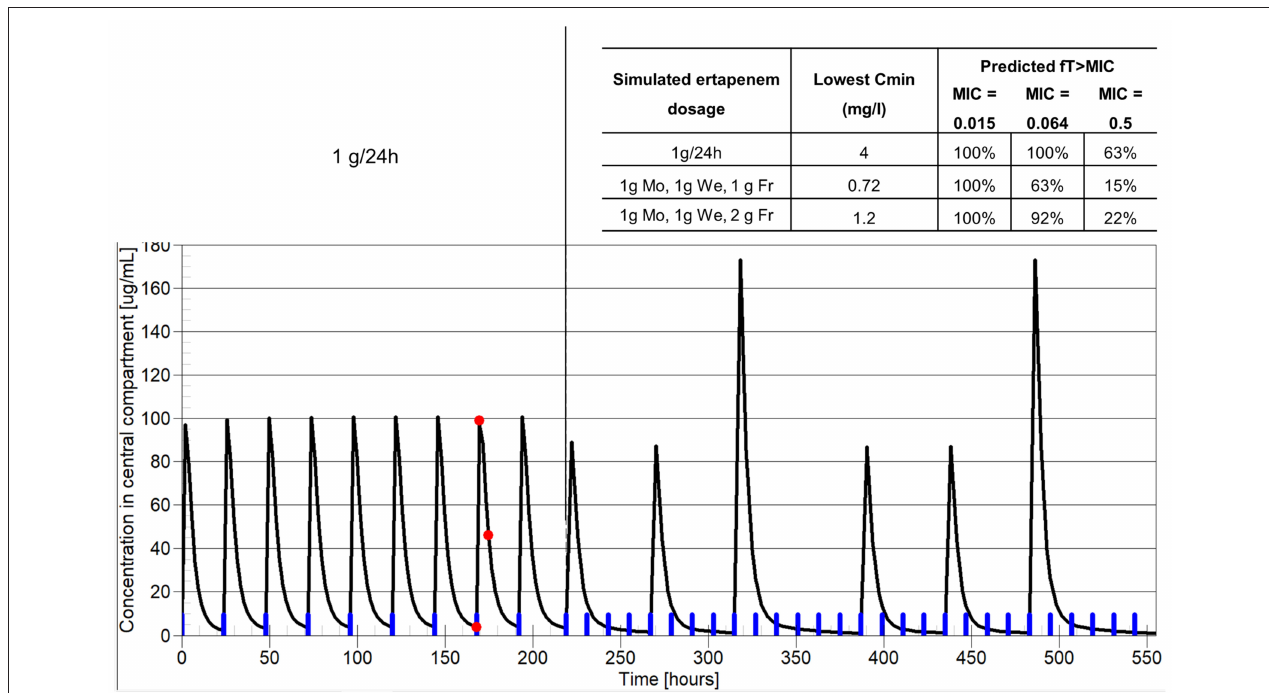
FIGURE 4 | Example of dosage individualization based on PK/PD in patient #5, treated with suppressive ertapenem for a persistent E. cloacae PJI. The x -axis shows the time and the y -axis represents ertapenem plasma concentration. Of note, this is not the real time of drug therapy, as past therapy before TDM was much longer. The blue marks on the x -axis show drug administrations. The red dots represent the patient-measured ertapenem concentrations. The black line represents model prediction. The vertical line separates the past therapy with 1 g/24h and predicted future therapy. The inserted table shows the predicted C min and PK/PD objective for three candidate dosage regimens and three possible MIC